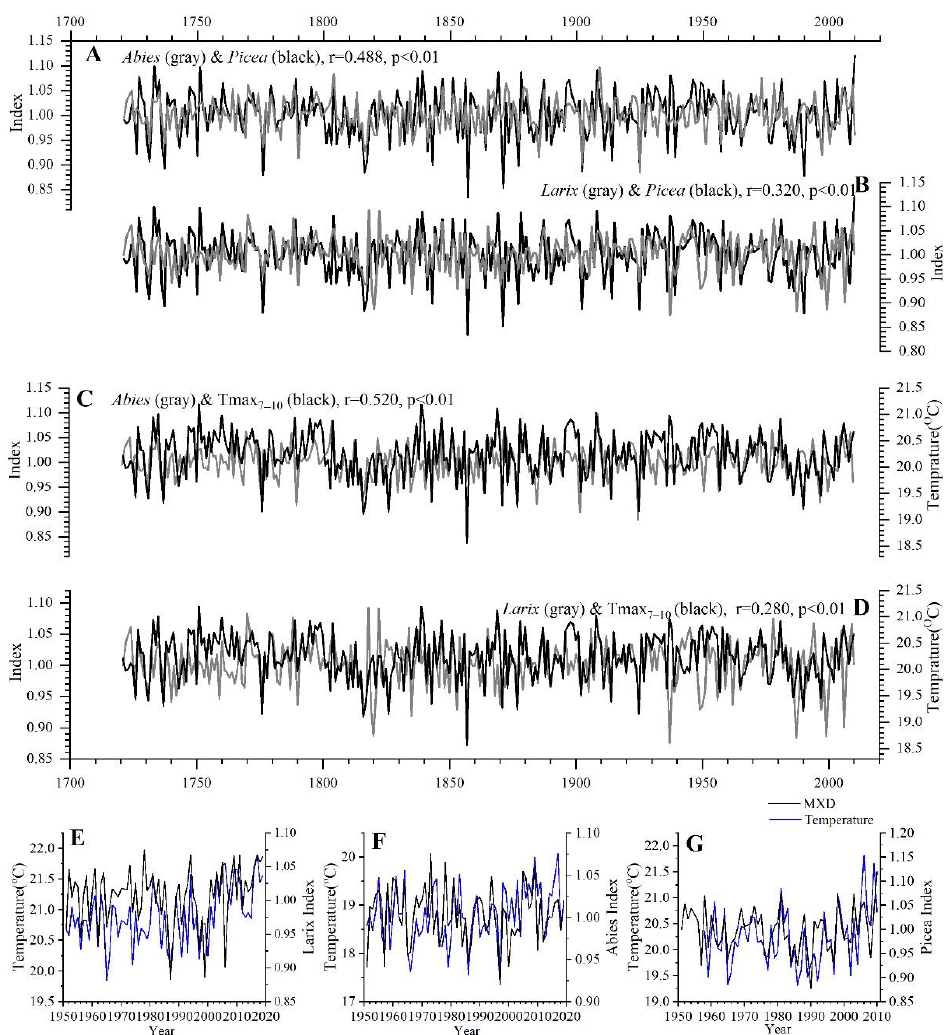
Figure 6. Comparison of MXD chronology of different tree species in this study and P. asperata in Yulong County during 1721–2010 [69]. ( A ) MXD (RES, black line) of A. delavayi and MXD (RES, gray line) of P. asperata in Yulong County. ( B ) MXD (RES, black line) of L. speciosa and MXD (RES, gray line) of P. asperata in Yulong County. ( C ) MXD (RES, black line) of A. delavayi and July–October maximum temperature reconstruction (Tmax 7–10 , gray line) in Yulong County. ( D ) MXD (RES, black line) of L. speciosa and July–October maximum temperature reconstruction (Tmax 7–10 , gray line) in Yulong County. ( E ) August–September mean temperature (CRU, 1951–2019) and MXD(RES) of L. speciosa . ( F ) September–October mean temperature (CRU, 1951–2019) and MXD(RES) of A. delavayi . ( G ) Observed Tmax 7–10 (1958–2005) and MXD(RES) of P. asperata in Yulong